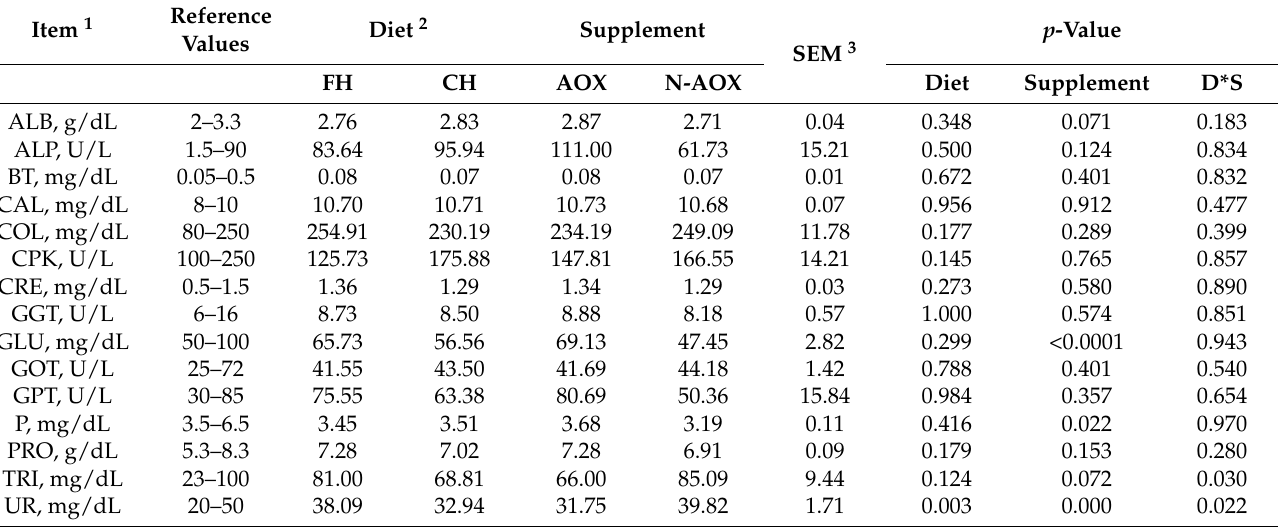
Table 3. Effect of different diets on biochemical parameters in dogs.